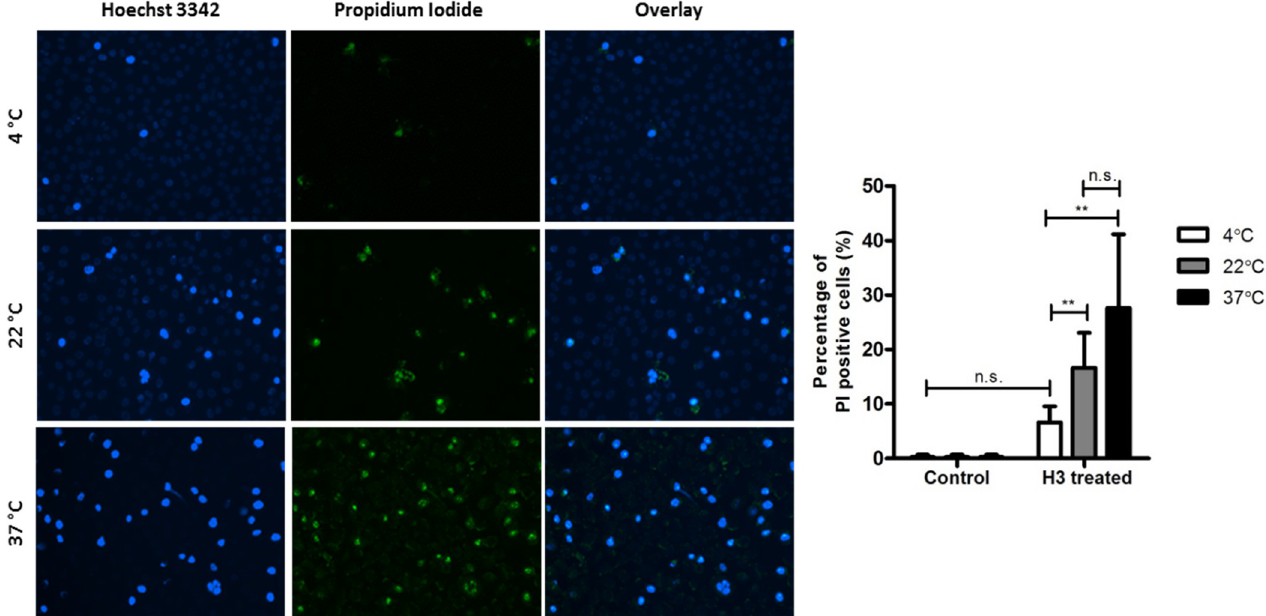
Fig 5. Temperature-dependent cytotoxicity of extracellular histone H3. Endothelial cells (EA.hy926) were incubated with 10 μ g/mL histone H3 in serum- free DMEM for 1 hour at 4˚C, 22˚C or 37˚C. Left panel: representative images from histone treated cells. Nuclei were stained using Hoechst 33342 (in blue) and necrotic cells were stained using PI (in green). Right panel: The number of PI positive cells were quantified in 6 random image fields using ImageJ software. Data is expressed as the mean ± SD of the average percentage of PI positive cells per condition (n = 5).